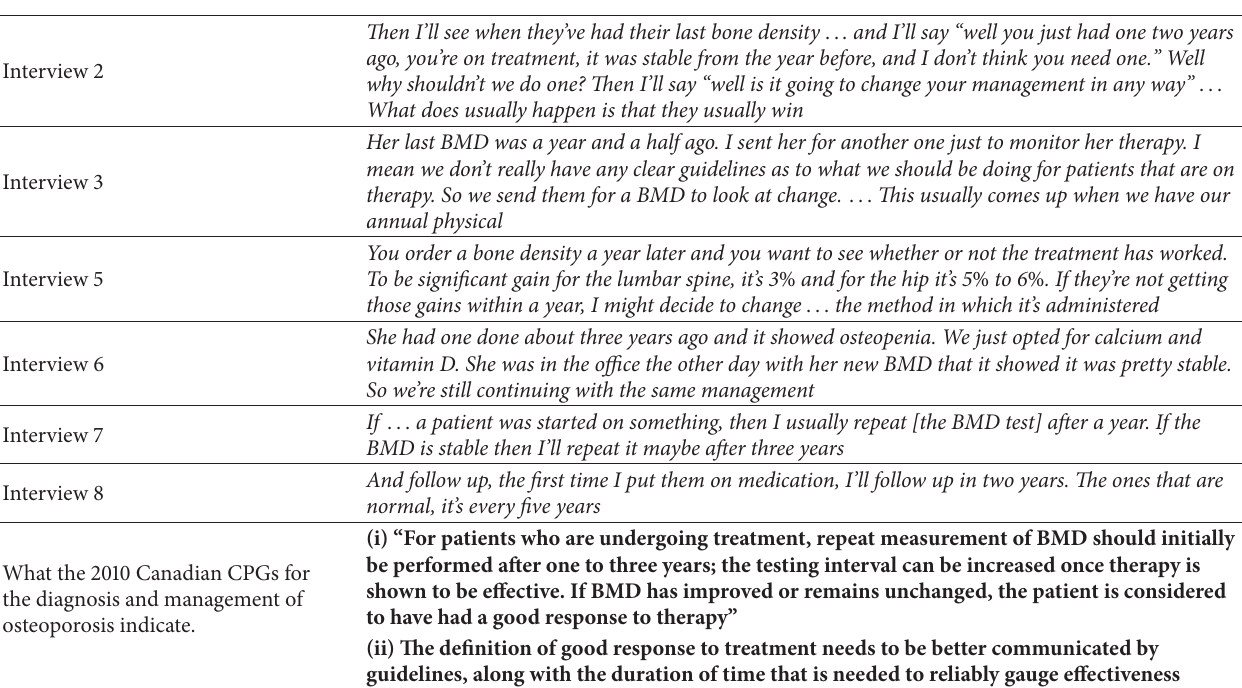
Table 3: Uncertainty about bone mineral density testing